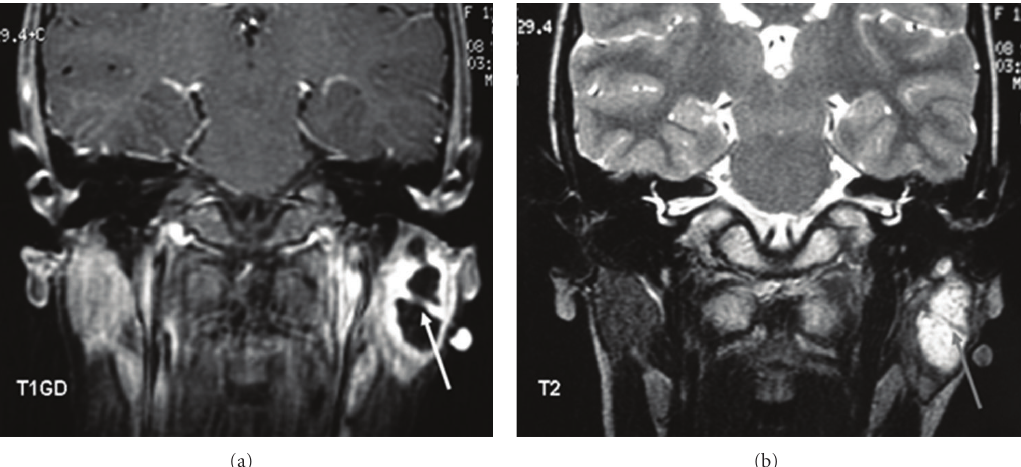
Figure 1: Coronal MR T1-contrast enhanced and T2-weighted images demonstrating the lesion in the left parotid gland (arrows: cyst with internal septum).